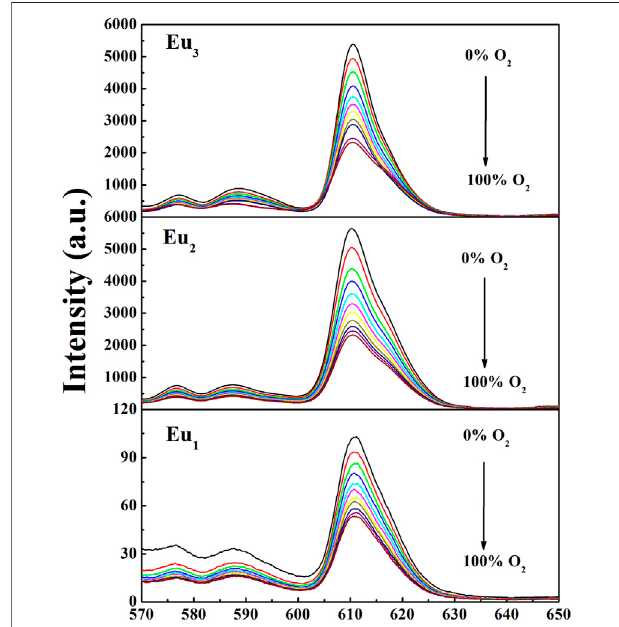
FIGURE 7 | PL spectra of Eu 1 , Eu 2 , and Eu 3 at different oxygen concentrations. Excitation (cid:2) 365 nm.